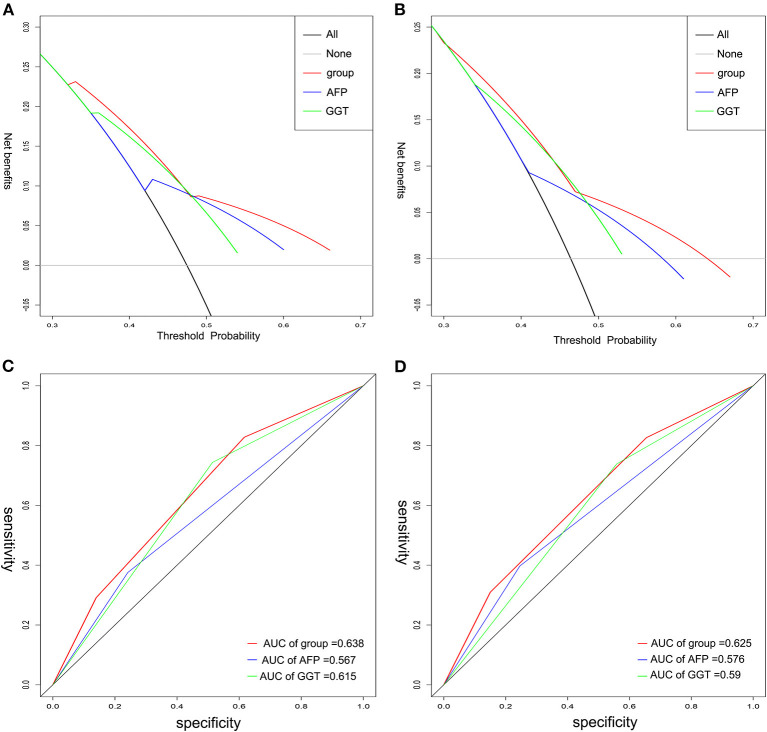
The time-dependent ROC and DCA curves of A-G score, AFP, and GGT on 3-year RFS and OS. Decision curve analysis for RFS (A) and OS (B) indicated the A-G score was better. The AUC of A-G score on RFS (C) and OS (D) was higher than that of either AFP or GGT. ROC, receiver operating characteristic; DCA, decision curve analysis.